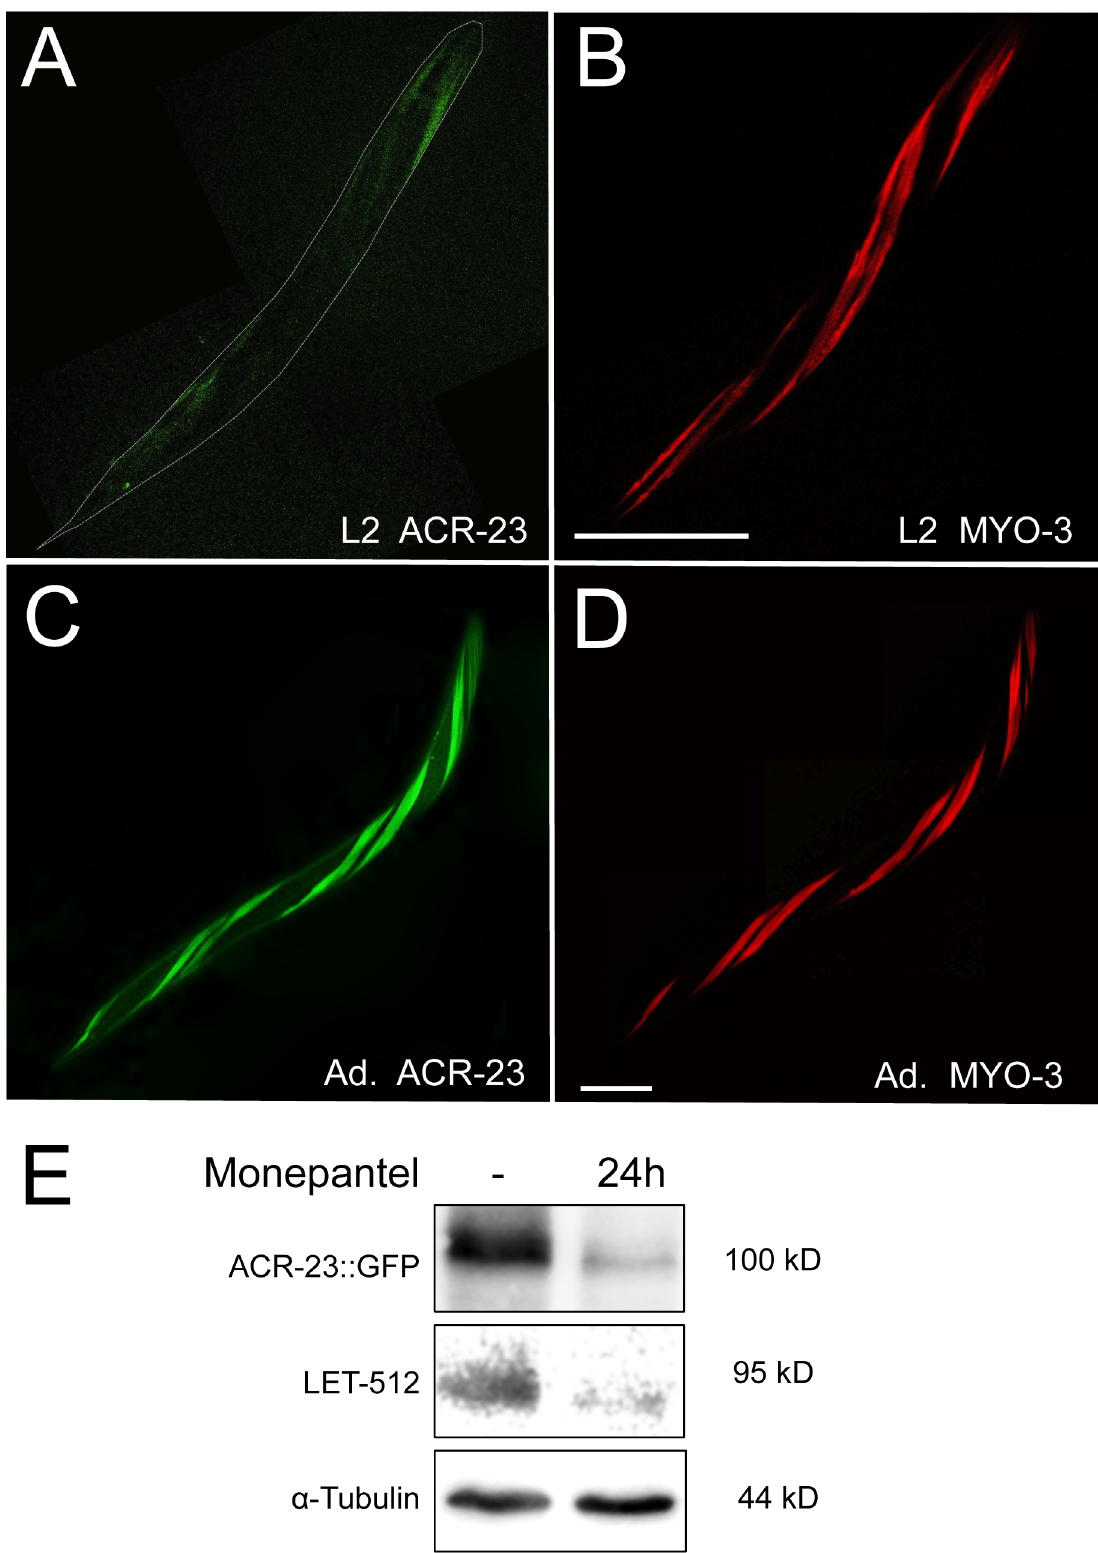
Figure 2. ACR-23 protein during C.elegans development. A) L2 larva expressing a acr-23::gfp transgene. Twisted morphology is caused by the transformation marker rol-6 ( su1006) . B) Same worm expressing myo-3::mCherry . C) and D) Expression in the adult. Bar, 50 m m. E) Analysis of ACR- 23::GFP expression in response to monepantel after 24 hours of exposure. Loading and general protein expression were tested with a -tubulin and LET-512, respectively.